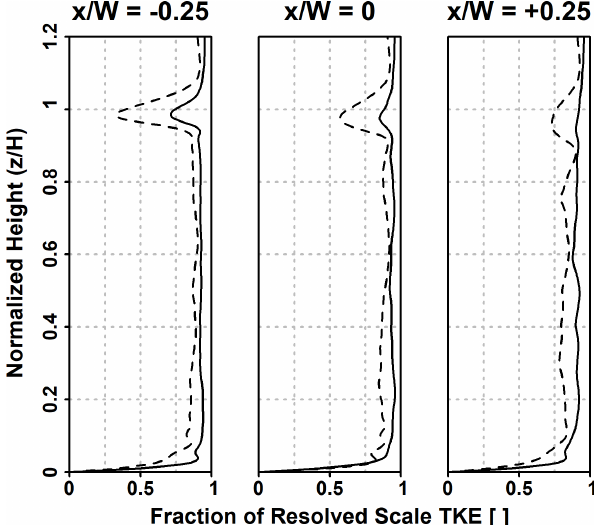
Figure 5. Fraction of resolved scale TKE of total (resolved and SGS) TKE for the three stations in the street canyon. Solid lines indicate fine mesh, and dashed lines indicate coarse